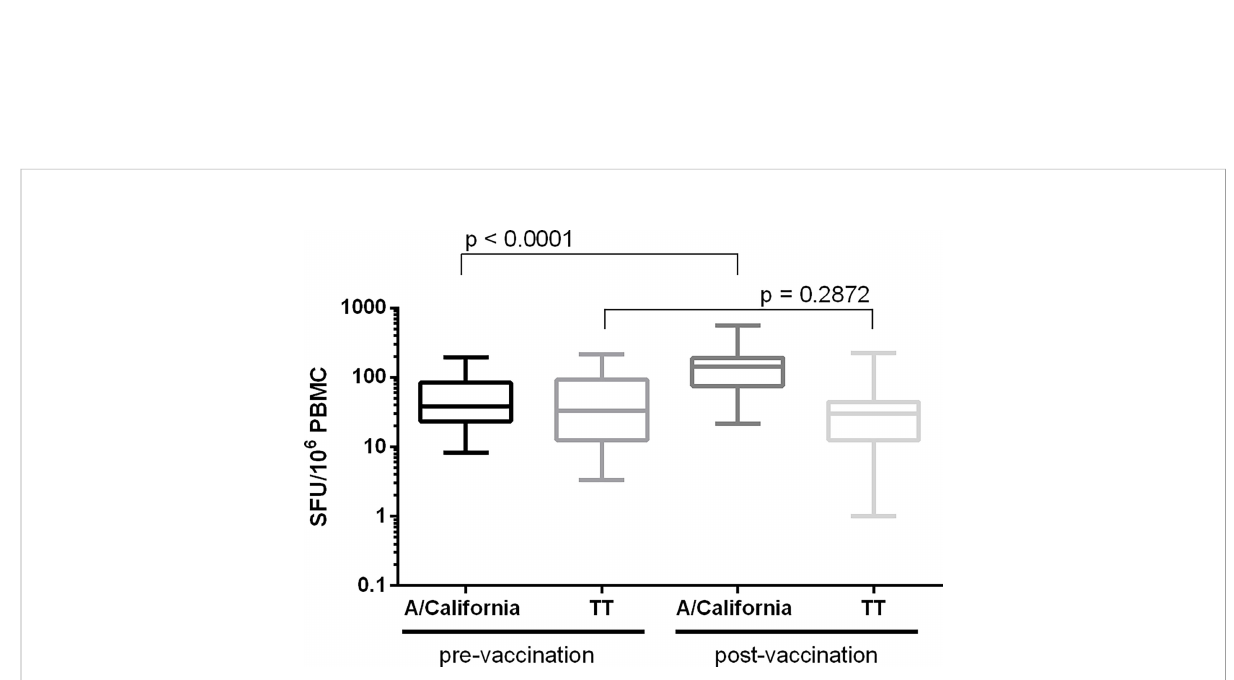
FIGURE 6 Determination of assay speci fi city. PBMC from 25 paired samples collected before and 7 days after the administration of a seasonal in fl uenza vaccine were stimulated with in fl uenza (split A/California) and control (tetanus toxin; TT) antigens. Background-subtracted values are shown as box plots. Differences in IFN- g spot forming responses between the pre- and post-vaccination samples following in vitro stimulation with either in fl uenza or TT antigen were examined. Wilcoxon matched-pairs signed-rank test was applied and p < 0.05 was considered statistically signi fi cant.